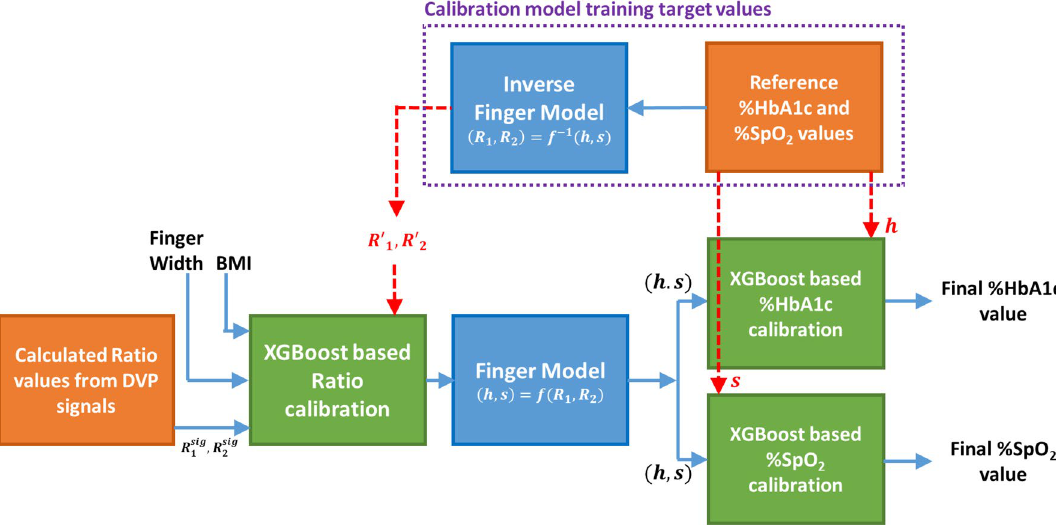
Figure 9. Proposed system overview diagram with calibration blocks. (h = normalized HbA1c, s = normalized SpO 2 ). The blue lines indicate the flow of data, and the red dotted lines indicate the target value for training the calibration models. The target values are absent in the testing